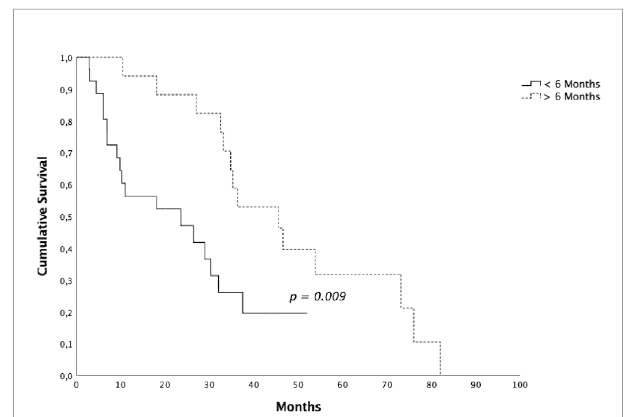
FIGURE 3 | Overall survival for patients submitted to radiotherapy <6 vs > 6 months after the start of androgen receptor targeted therapy.